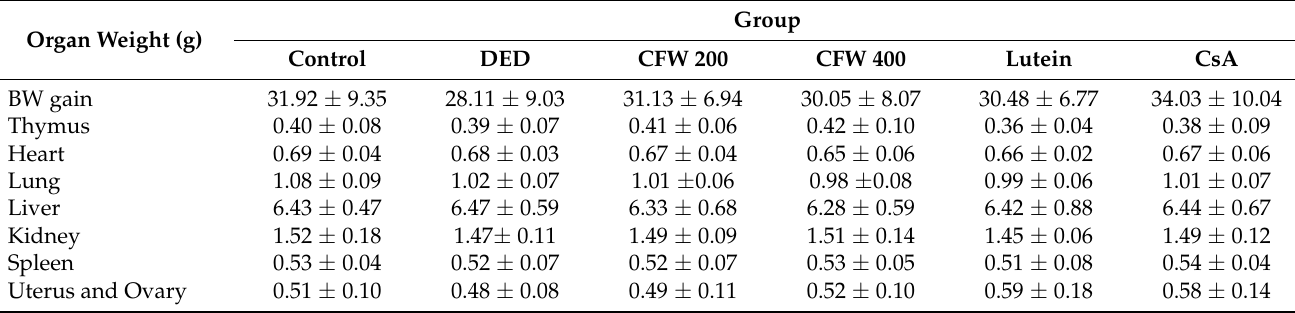
Table 1. Effect of oral administration of CFW on the changes of the body weight and organ weight in PM 2.5 -exposed SD rats. Organ Weight